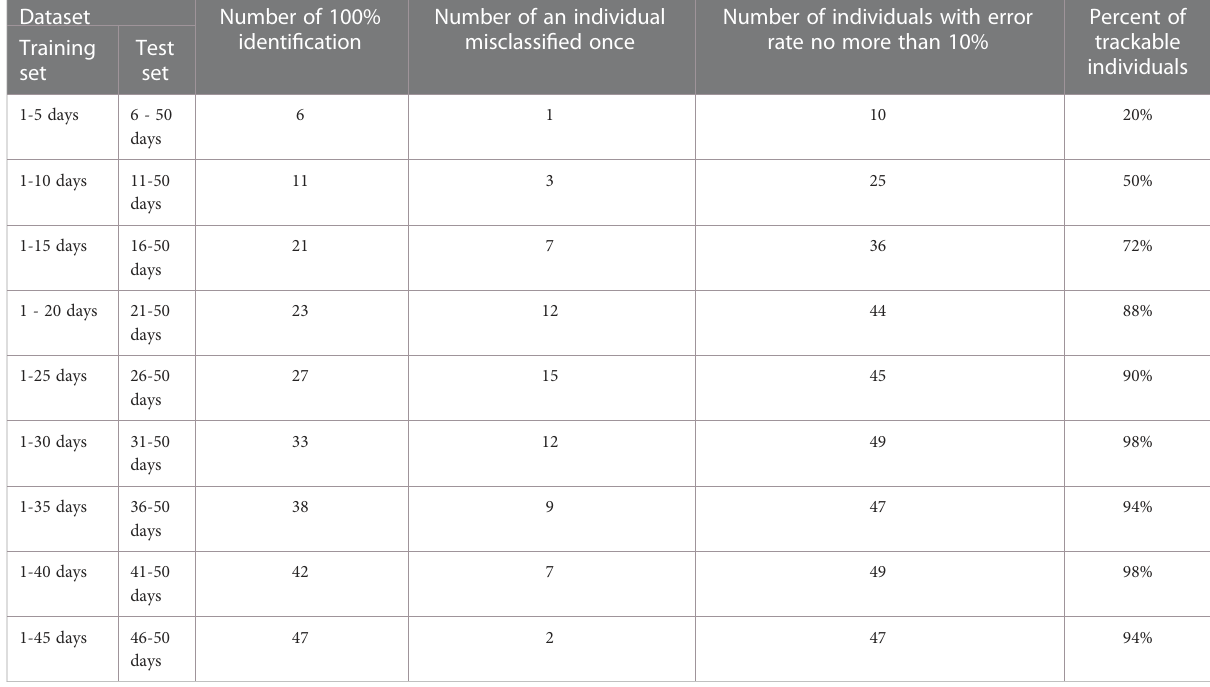
TABLE 2 The statistics for results of tracking recognition on different time scales.